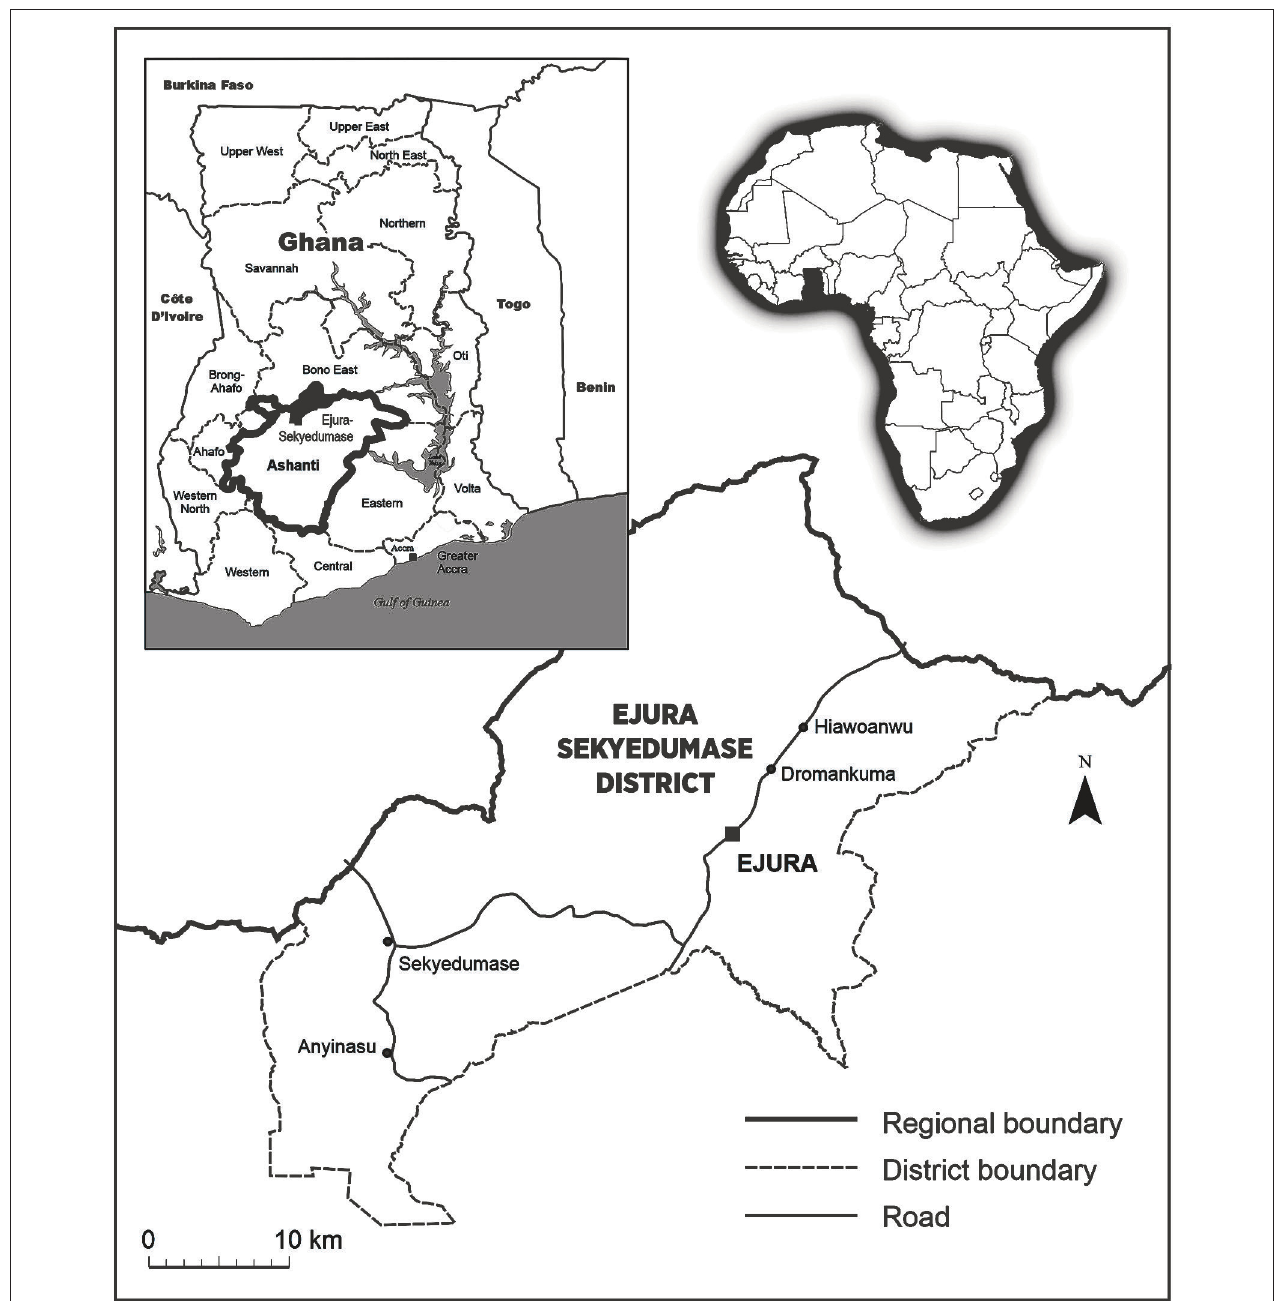
FIGURE 1 | Map of the Study